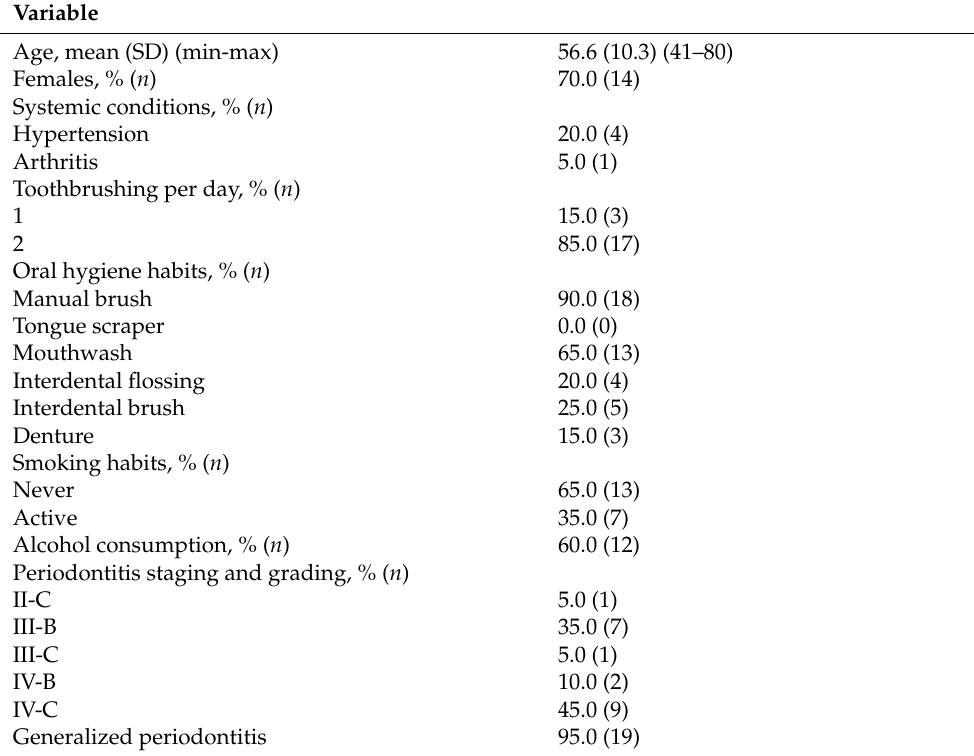
Table 1. Participants baseline sociodemographic and clinical